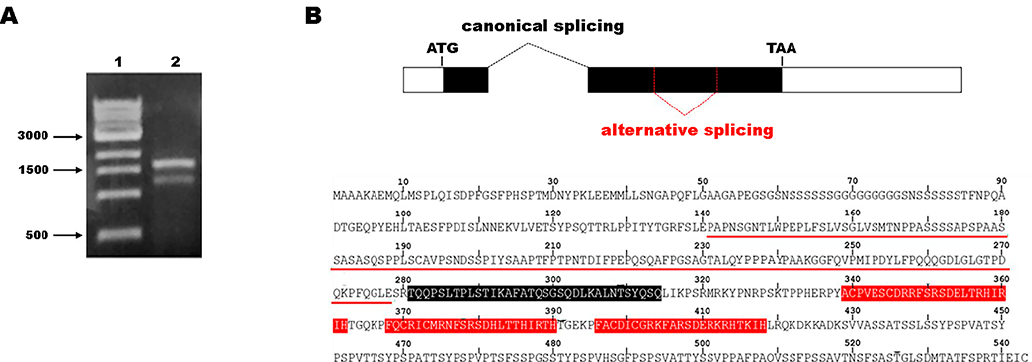
Figure 1. Identification of the EGR1 splicing isoform. ( A ) Electrophoresis of the PCR products related to EGR1 coding DNA sequence (CDS) amplification. Lane 1: 1 kb marker (New England Biolabs, NEB); lane 2: PCR reaction for EGR1 CDS. ( B ) On the top, schematic representation of the two EGR1 transcript isoforms. The rectangles represent the two exons of the EGR1 transcript, with the black region representing the coding sequence. Alternative splicing is indicated by dashed red lines. On the bottom, amino acid sequence of the EGR1 protein. The underlined amino acid region represents the sequence missing in the putative alternative EGR1 isoform; red sequences represent the zinc finger domains; the black sequence represents the repression domain.